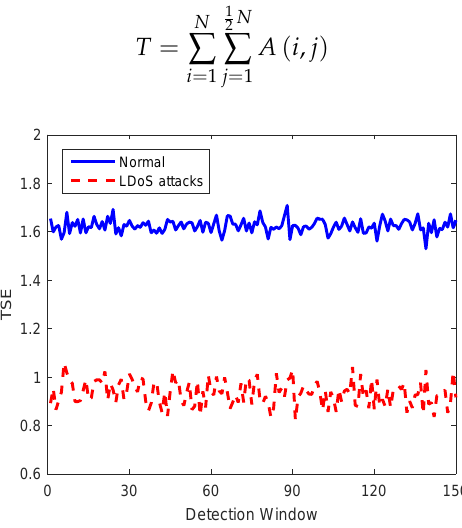
Figure 4. Total signal energy